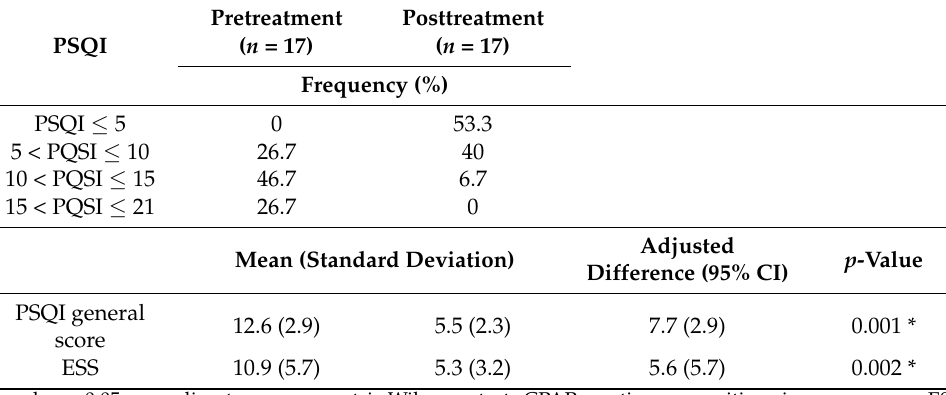
Table 4. PSQI and ESS score at baseline (pretreatment) and after 3 months of CPAP treatment